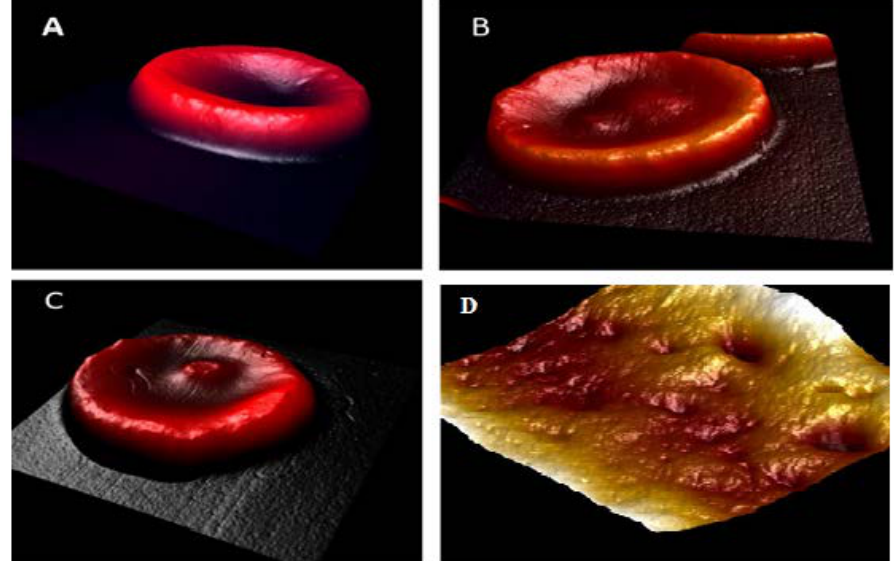
Figure 3. The RBC (red blood cell) shape by AFM (atomic force microscopy) investigation of the ( A ) normal control; ( B ) moderate smoker; ( C ) and heavy smoker; and ( D ) surface profile for a heavy smoker [12]. Table 3. Statistical analysis of parameter of the roughness values of the RBCs (red blood cells) of normal, moderate, and heavy smokers, and pre-diabetic and diabetic subjects. Parameter Normal (Control) Moderate Smokers Heavy Smokers Pre-Diabetic Diabetic